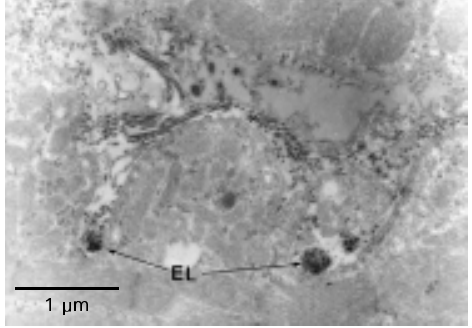
Figure 4 - Diaphragm muscle from an aged (18 months) rat. An abnormal oxytalan fiber (ar- row) showing haphazardly ar- ranged microfibrils